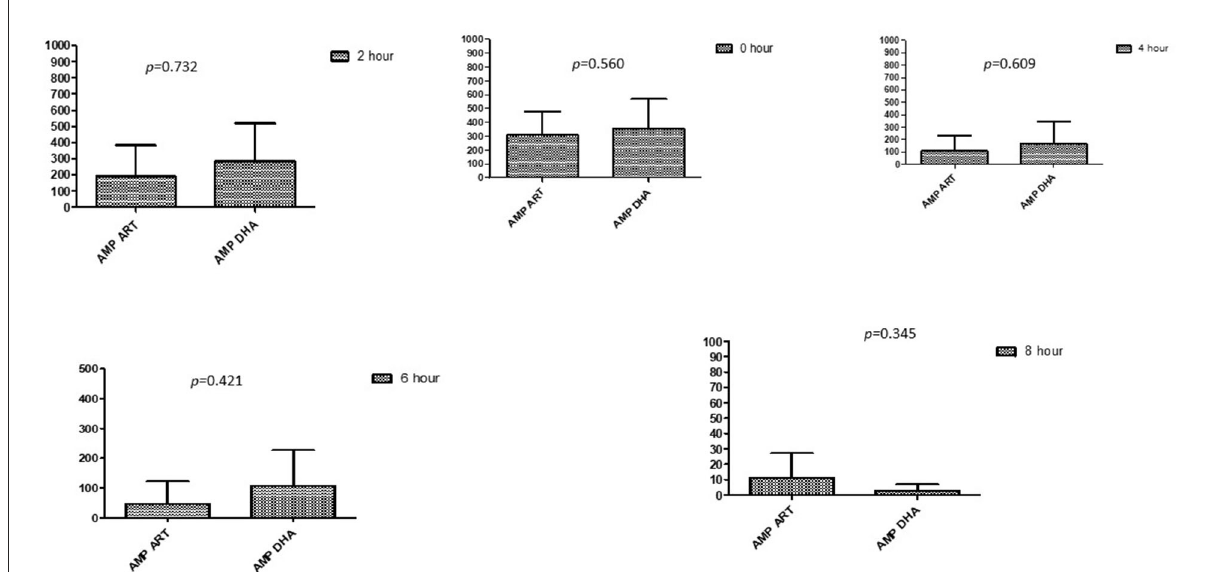
FIGURE3 Comparison of ampicillin’s minimum inhibitory concentrations ( µ g/mL) when combined with ART and DHA on E. coli. AMP ART, Ampicillin combined with ART; AMP DHA, Ampicillin combined with DHA; p < 0.05 indicate a significant difference among MICs of antibiotic combined ART and DHA.